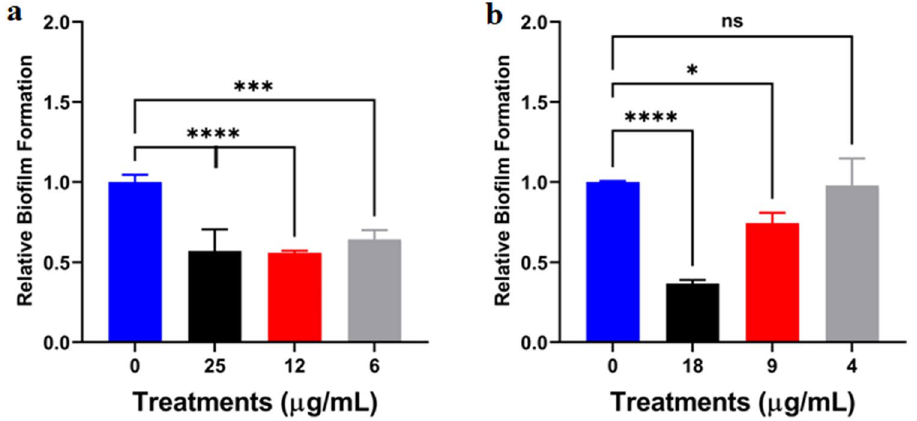
Figure 3. Relative effect of extracts from C. chinensis on pre-formed biofilms of C. neoformans at 37 °C. ( a ) Effect of crude extracts; and ( b ) Effect of clarified extracts. Cryptococcal cells grew on DMEM supplemented with glucose for 24 h before extracts were applied. Biofilm formation on each condition was normalized to control without any extract (0 µg/mL). Experiments were performed in biological triplicate and technical duplicate. Error bars indicate standard deviation. Statistical analysis was performed using a one-way ANOVA and a Dunnett’s multiple comparison test with a p-value of 0.05. **p < 0.01; ***p < 0.001 and ****p < 0.0001. Figures were created using GraphPad Prism